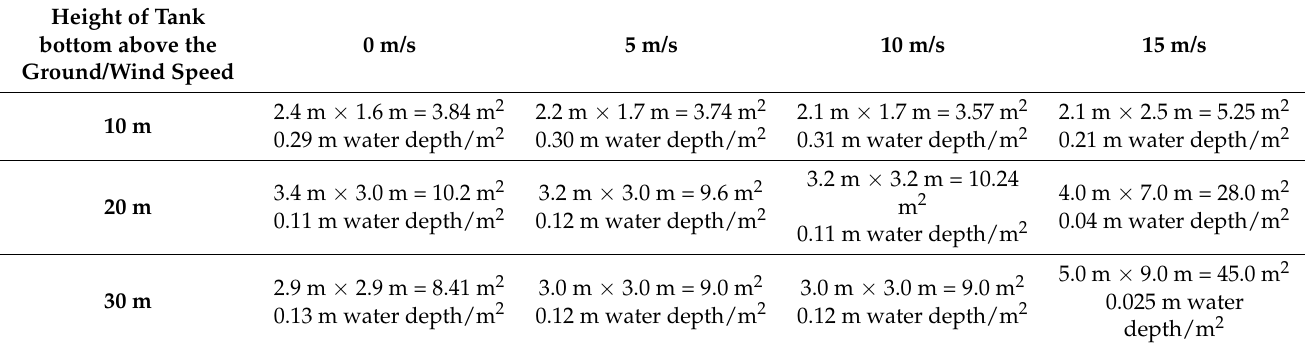
Table 1. Influence of wind speed and height of the tank bottom above the ground on the region covered by water and the average water amount on the ground while the helicopter was